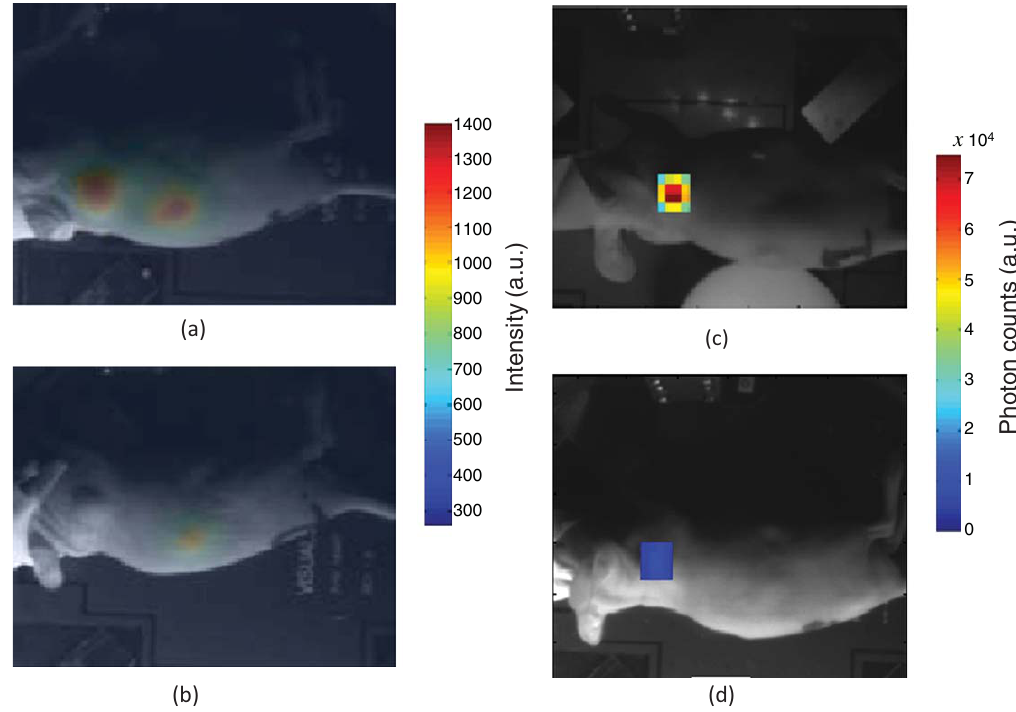
Fig. 9. In-vivo fluorescence intensity map of xenograft mouse with (a, c) high HER2-expressing human tumor model (BT474) and (b, d) no HER2-expressinghumantumormodel(MDA-MB468),3hoursafterinjectionoftheHER2-specificAffibody ® (His6-ZTaq-GS-Cys)conjugated to DyLight 750. Figures (a) and (b) were imaged by CW CCD camera, the data on figures c and d were captured by a time-resolved